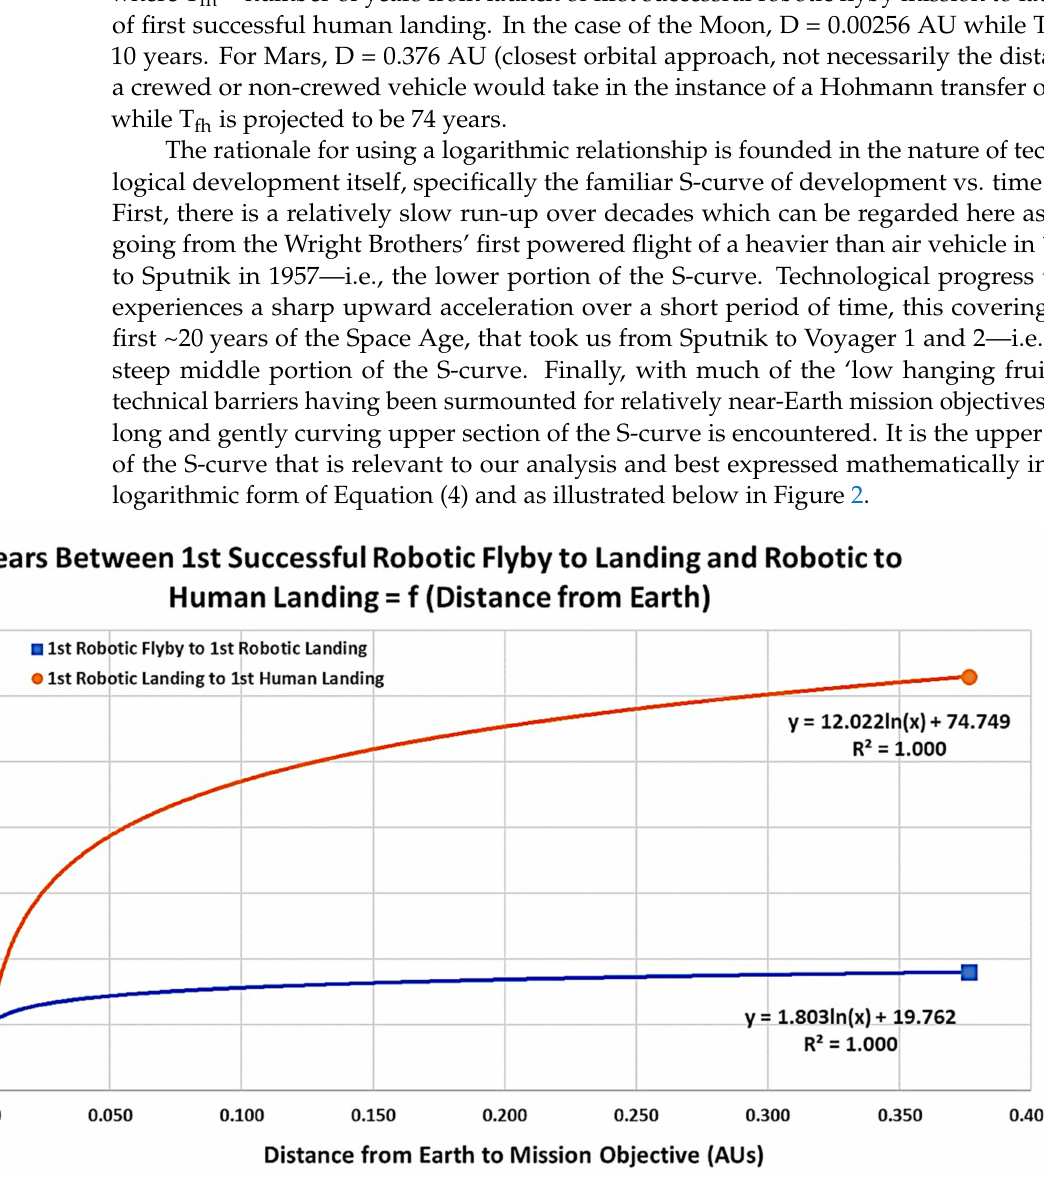
Figure 2. Number of years separating launch of first successful robotic flyby to robotic landing and first successful robotic landing to human landing, for Moon and Mars missions. Note: Launch of first successful human landing on Mars is assumed to occur in calendar year 2038 (average of years 2037 and